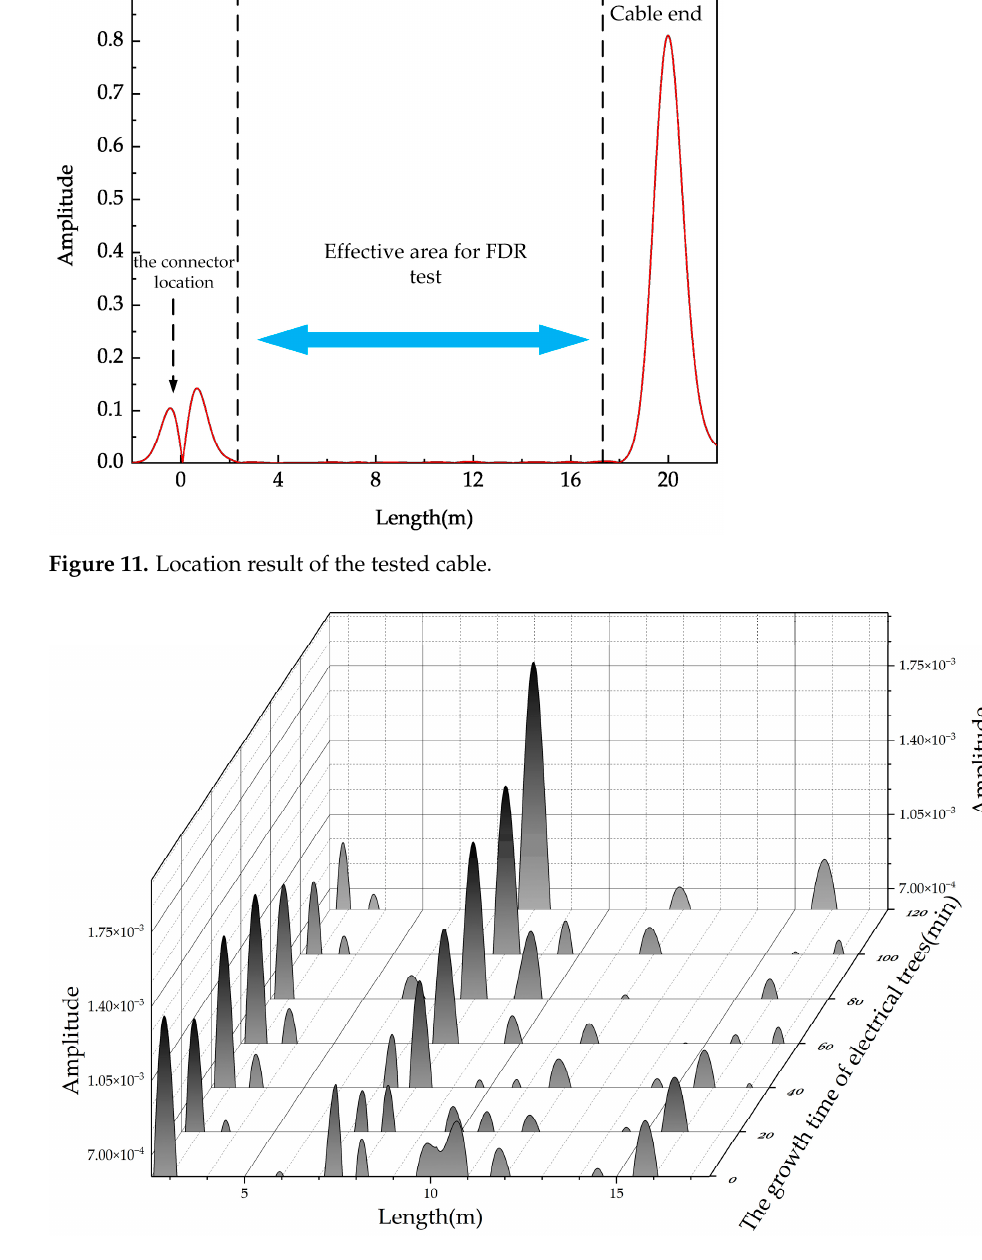
Figure 12. Location spectrum of cable with branch-pine trees at 8.2 m.